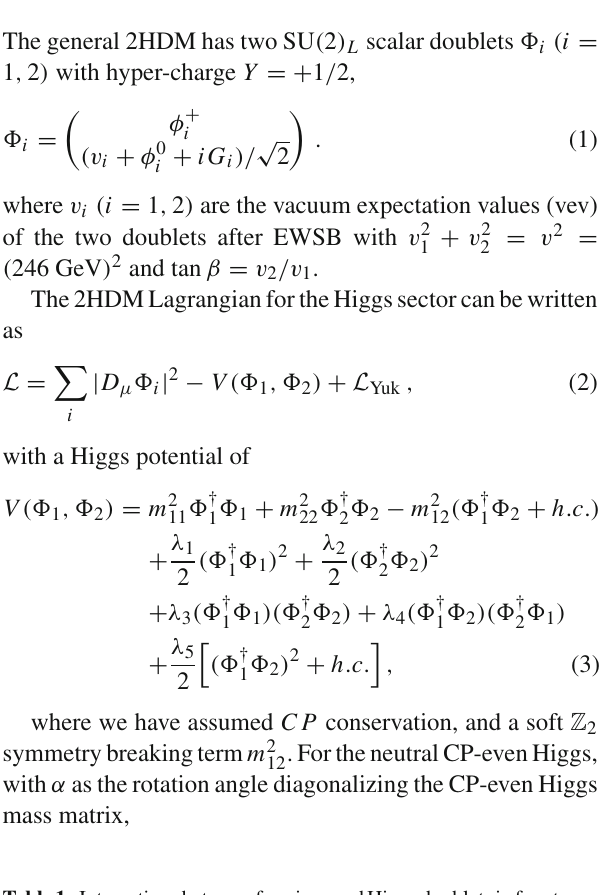
Table1 InteractionsbetweenfermionsandHiggsdoubletsinfourtypes of 2HDM Up-type Down-type